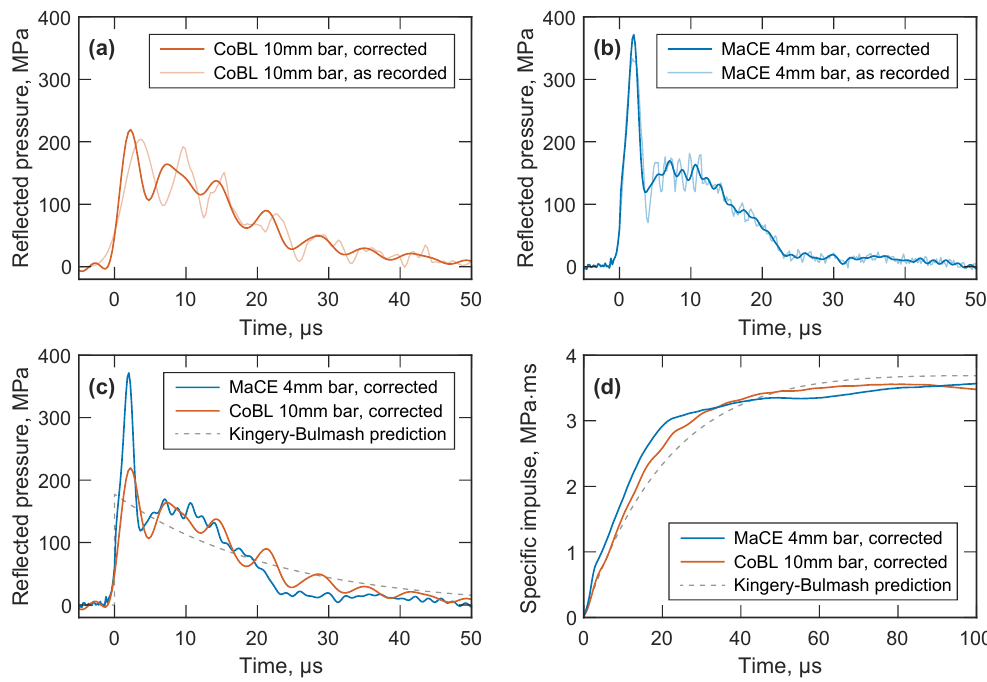
Figure 5. Reflected pressure measurements for a spherical PE10 charge at Z = 0.18 m/kg 1/3 , using ( a ) 10 mm diameter pressure bars in CoBL and ( b ) 4 mm diameter pressure bars in MaCE. ( c ) Reflected pressure and ( d ) specific impulse comparisons of dispersion-corrected MaCE and CoBL data, and the semi-empirical Kingery–Bulmash